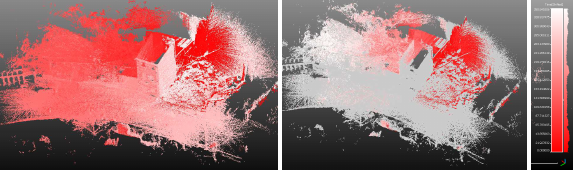
Figure 9. ZEB point cloud presented in scalar colours according to acquisition progression with time variable (0-350sec, from red to white), left; first two minutes acquisition sample (right).